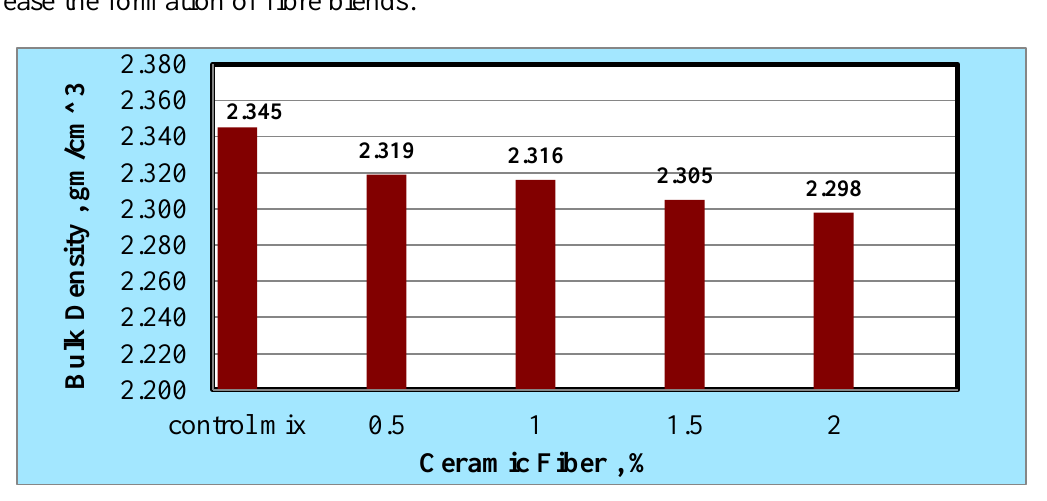
Fig. 4. Effect of Ceramic Fiber on Bulk Density of Asphalt